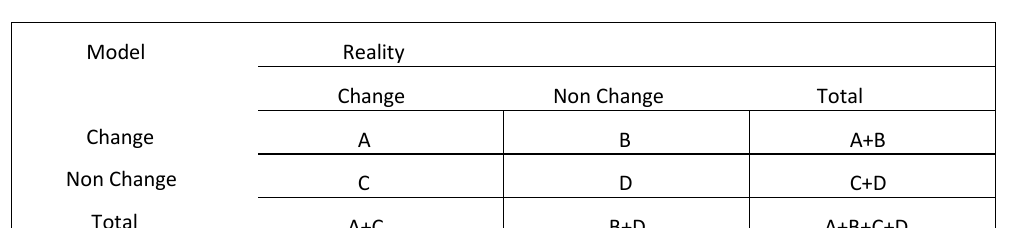
Figure of Merit (Equation 1) is a method to evaluate resemblance between actual and simulated map suggested first time by [32]. If simulated map have a high goodness of fit to actual map, Figure of Merit will be high and vice versa.